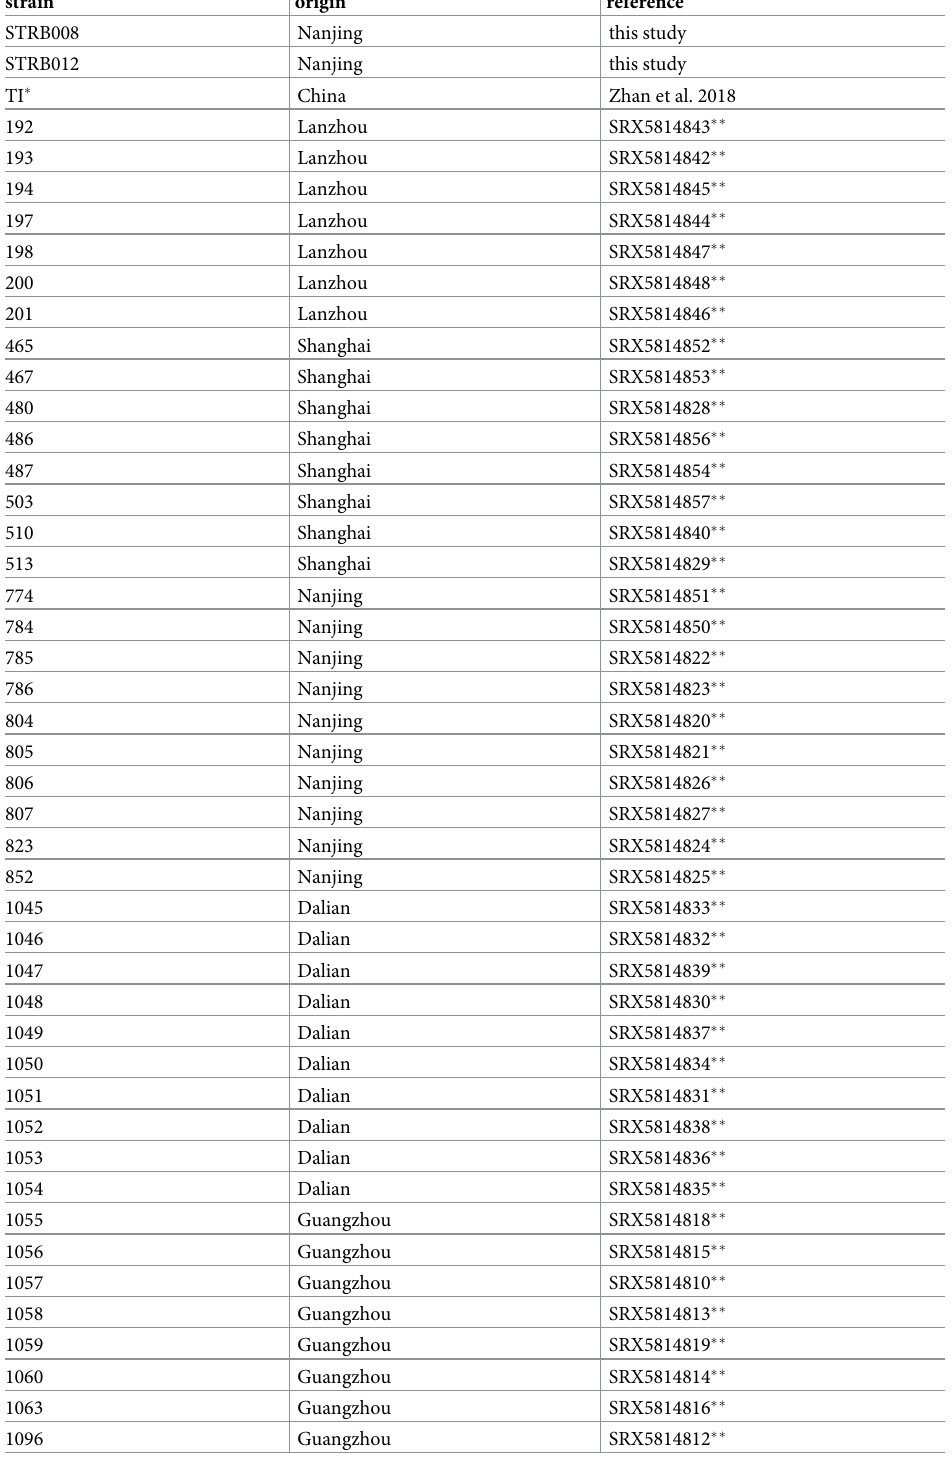
Table 1. Strains used in this